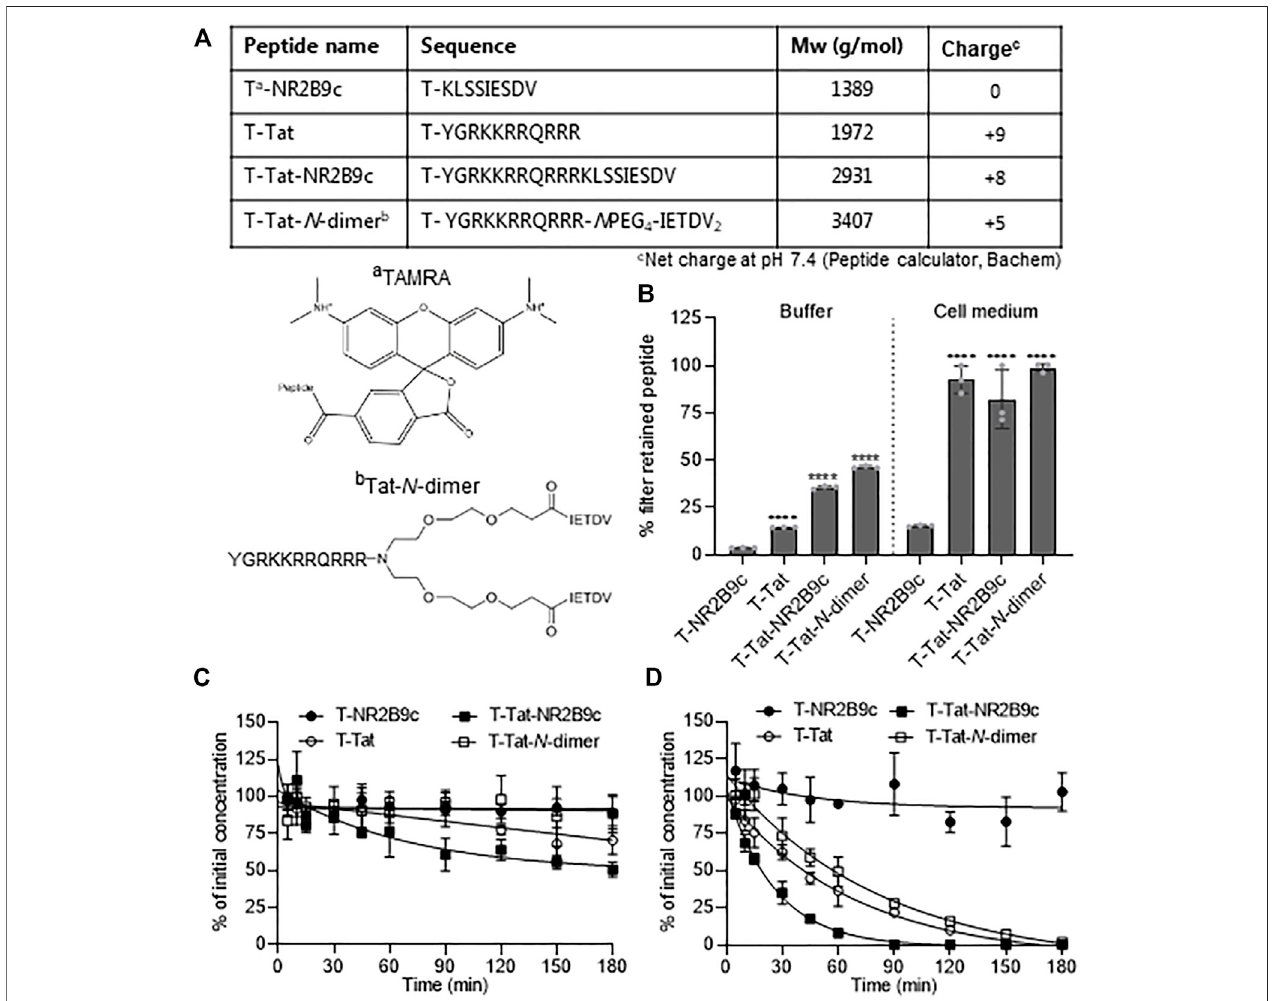
FIGURE1| Peptideoverview,stability,andaggregation/adsorptioncharacteristics. (A) Tablewithprimarypeptidesequences,molecularweights,andnetcharges at pH 7.4. Chemical structure of the fl uorophore TAMRA (T) and Tat- N -dimer (Bach et al., 2012). (B) Peptide self-association and/or adsorption to serum proteins assessed by centrifugal centrifugation. Mean ± SD ( N = 3); ****: p < 0.0001 when compared to T-NR2B9c (one-way ANOVA with Tukey ’ s multiple comparisons test). Peptide stability during 3-h incubation in 37 ° C cell media (C) or rat plasma (D) . Mean ± SD ( N = 3).